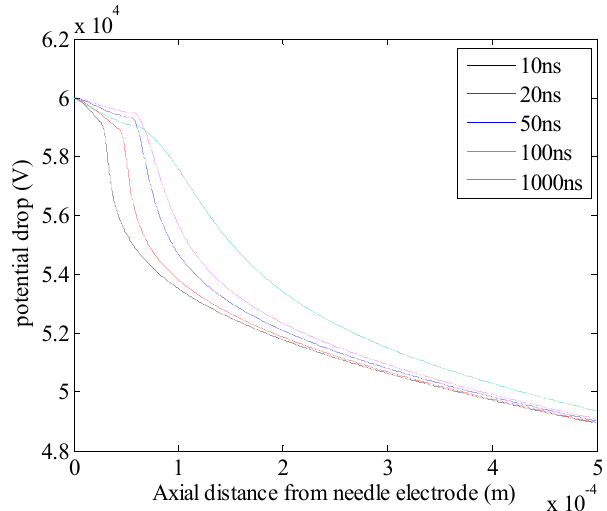
Figure 6. Potential drop along the needle-sphere axis as a response to 1.2 PDIV with 10 mm needle-sphere electrode